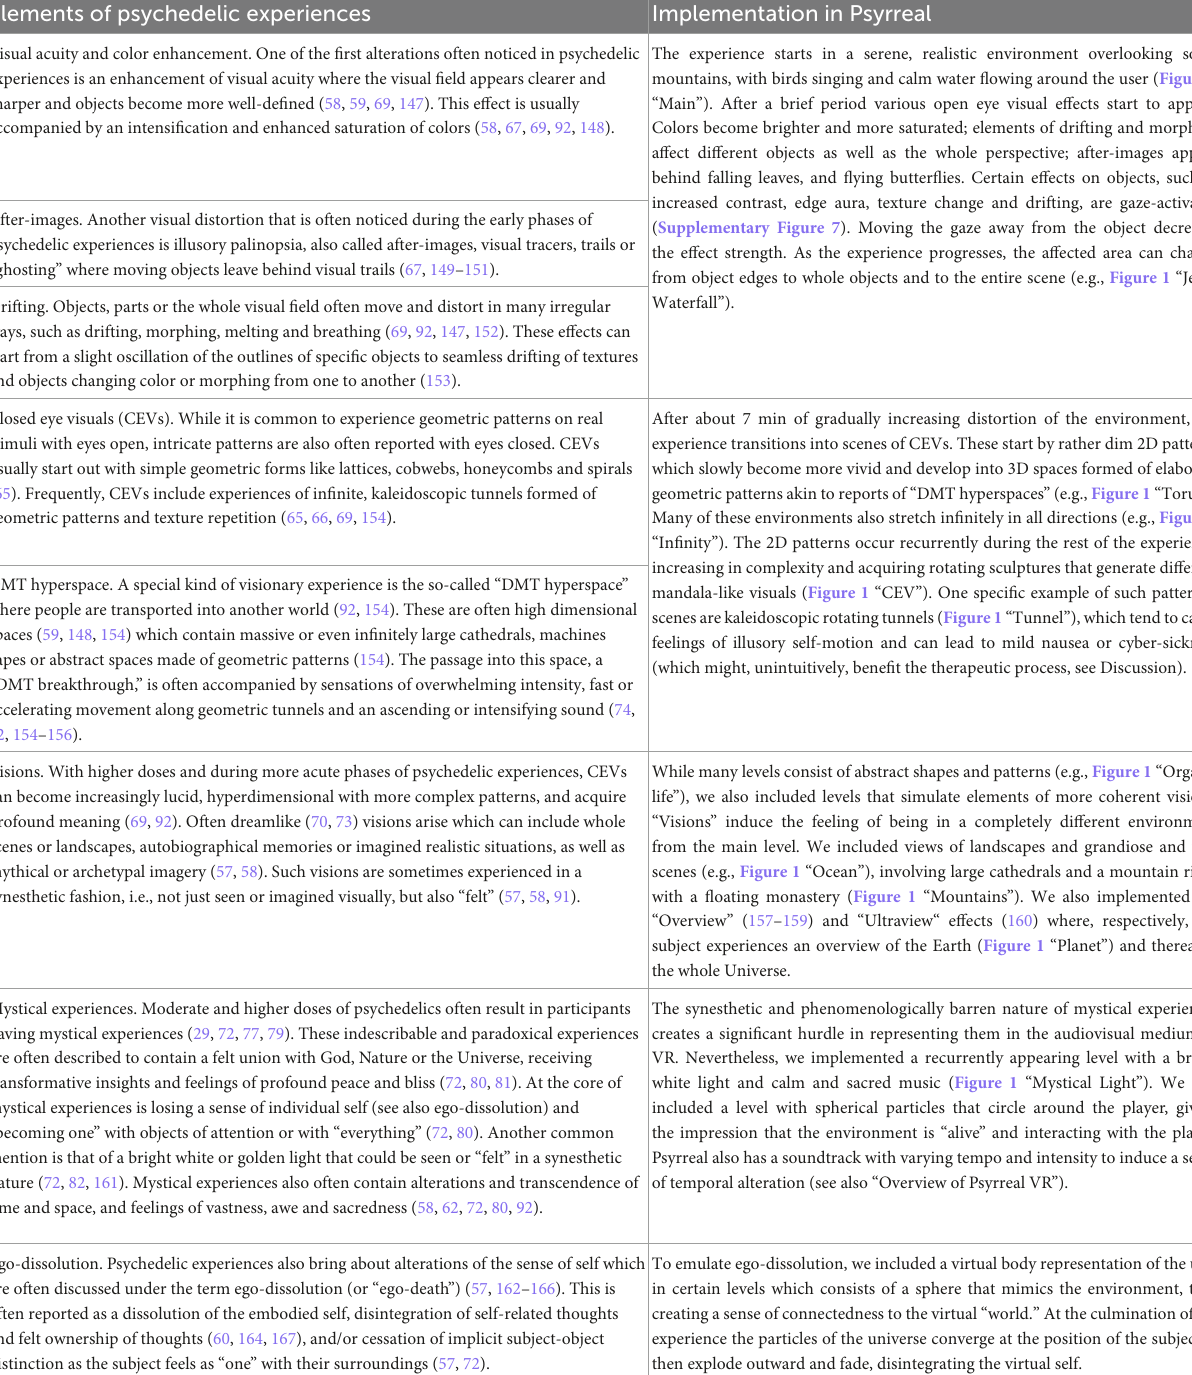
TABLE 1 Overview of elements and concepts common to psychedelic experiences and examples of their implementation in